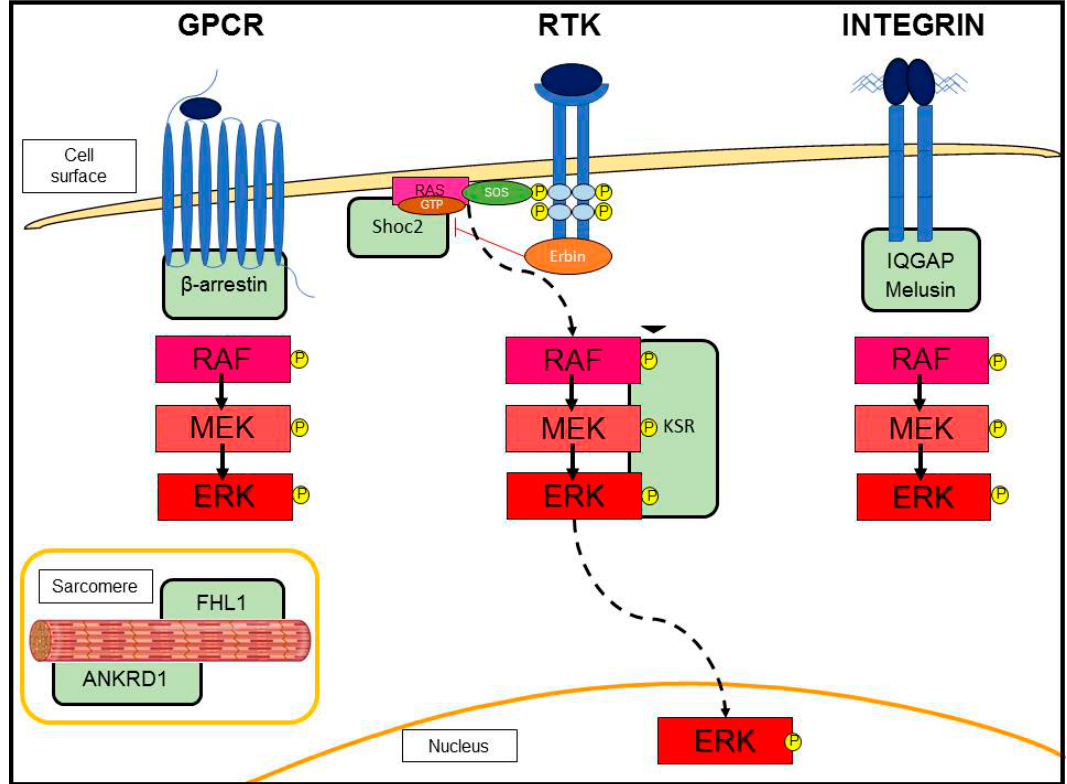
Figure 2. Schematic view of the ERK pathway in response to growth factors, hormones, and mechanical stress. The prototypical activation of ERK cascade is initiated at the plasmamembrane by receptor tyrosine kinases (RTKs) in response to growth factors. Activated RTKs promote RAS stimulation through recruitment of SOS exchange factor. RAS facilitates the activation of MEK-ERK cascade through serial phosphorylation. Once activated, ERK translocates to the nucleus and phosphorylates transcription factors, modulating the transcription of hundreds of genes. In cardiac myocytes under stress (aortic stenosis and hypertension), ERK is activated in response to G protein-coupled receptors (GPCRs), and/or “stretch-sensitive” sensors, such as membrane bound integrins, and the sarcomere. The activation of ERK cascade is regulated by scaffold proteins (KSR, Shoc2, Erbin, β -arrestin, IQGAP, Melusin, FHL1, and ANKRD1), which bind components of the RAF-MEK-ERK module, facilitating their functional interaction and subcellular localization. Scaffolds also link the ERK activation to specific upstream signal and affect the duration of the signal.